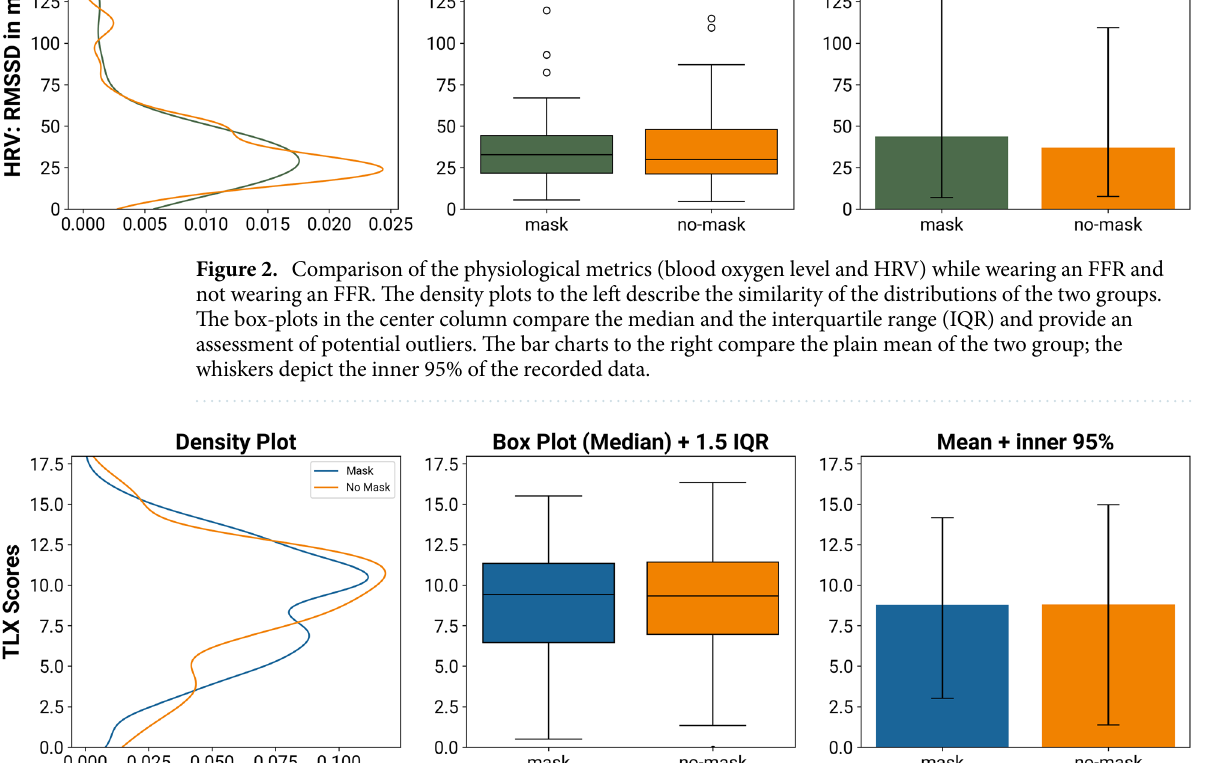
Figure 3. Comparison of the subjective load ratings (NASA TLX) while wearing an FFR and not wearing an FFR. While the distribution reveals minor differences between the groups, these are averaged out when comparing mean and median